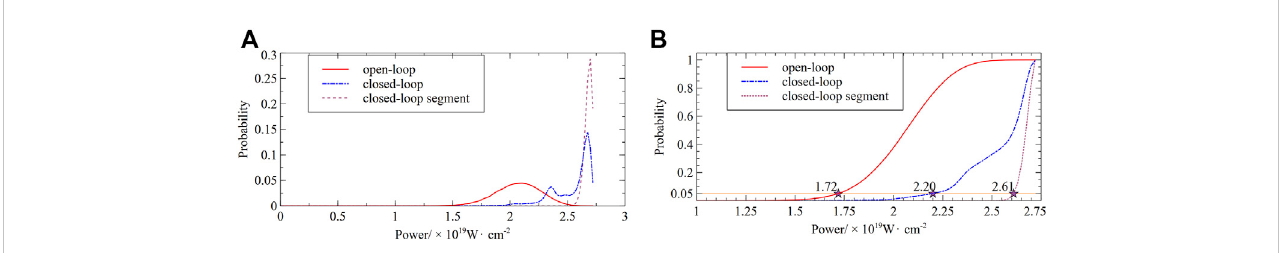
FIGURE 8 Performance of an active beam-pointing stabilization control system: (A) Probability distribution of laser intensity at the center of the target; (B) Probability of laser intensity exceeding a certain value.